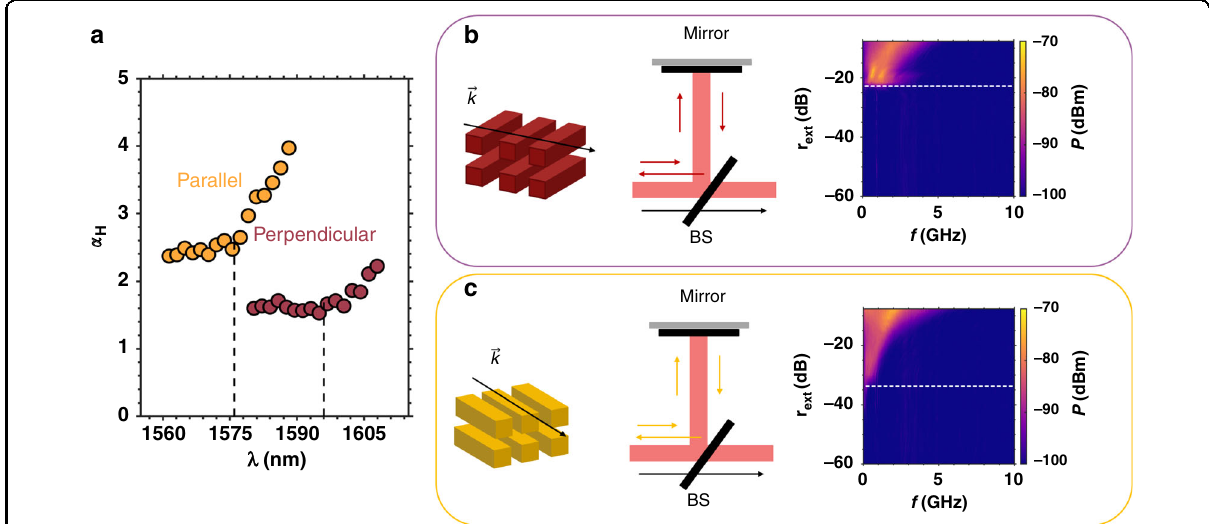
Fig. 3 QDash polarization anisotropy. ( a ) Spectral α H -factor at threshold for the parallel and perpendicular QDash lasers. Sketch of the external optical feedback operation of the ( b ) perpendicular and ( c ) parallel device. ~ k denotes the wave propagation direction and its interaction with the nanostructure materials that can be either perpendicular or parallel to the waveguide structure. BS beam splitter. The critical feedback level r crit is marked by the white dashed